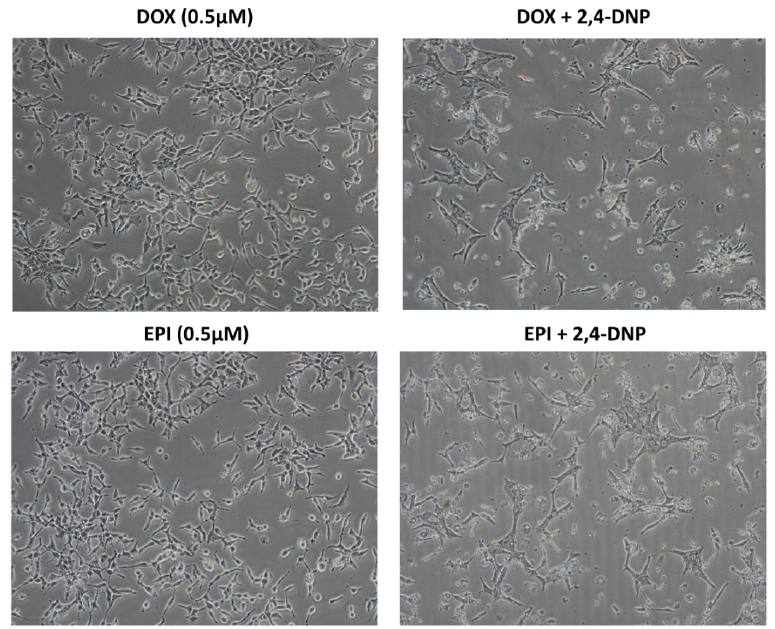
Figure 4. Morphological changes of LNCaP cells. The cells were treated for 48 h with 2,4-DNP (100 µM), DOX (0.5 µM) and EPI (0.5 µM) or combined (2,4-DNP + EPI, 2,4-DNP + DOX) (magnification ×100).